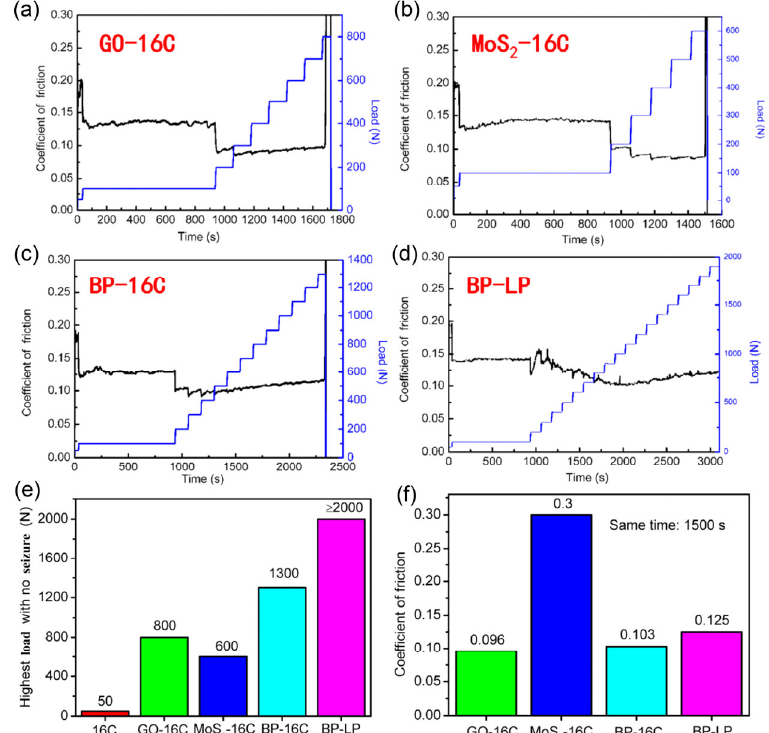
Fig. 14 The results of the load-climbing tribological tests. The tested samples include four lubricants: (a) GO-16C: graphene oxide were dispersed in hexadecane; (b) MoS 2 -16C: MoS 2 nanosheets were dispersed in hexadecane; (c) BP-16C: BP nanosheets were dispersed in hexadecane; (d) BP-LP: BP nanosheets were dispersed in liquid paraffin; (e) Highest load with no seizure of these lubricants; (f) COF of different samples at same